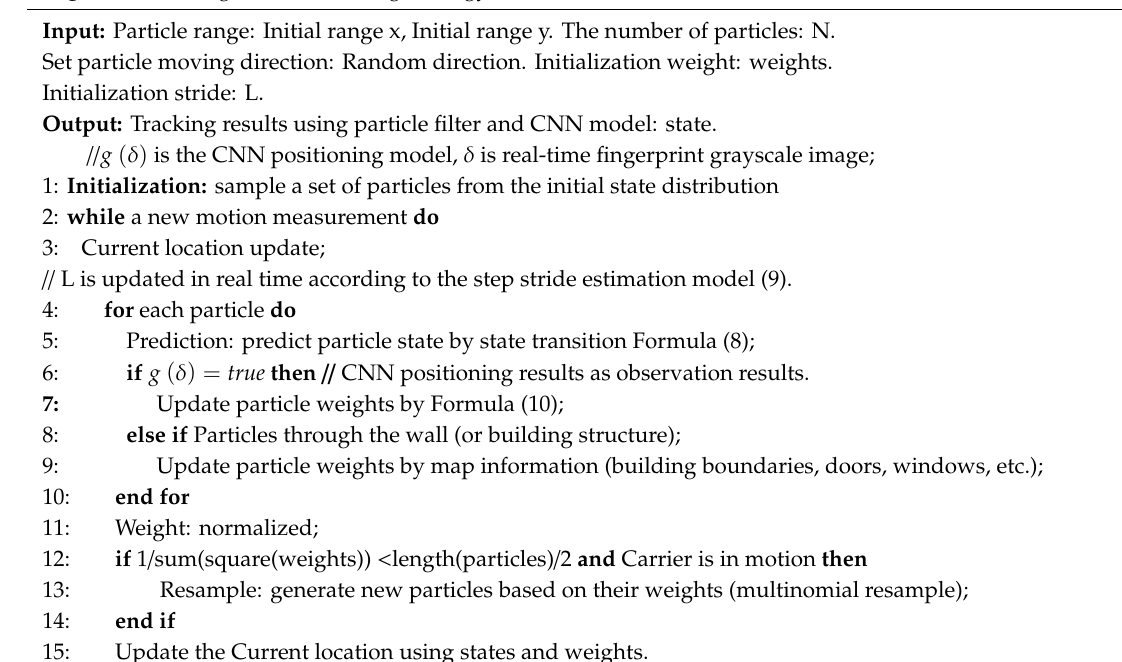
Algorithm 1 : Integrated Positioning Strategy Based on Particle